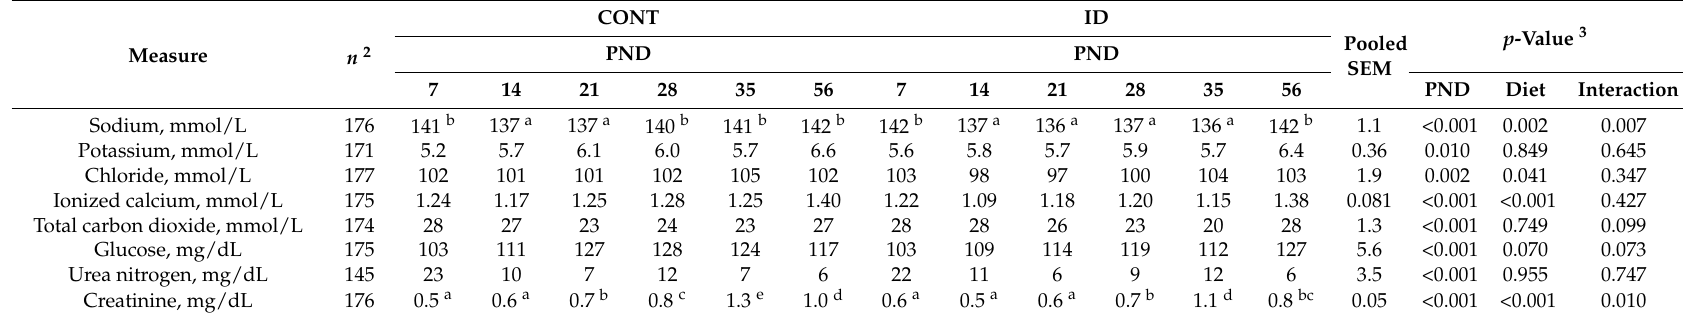
Table 3. Clinical blood chemistry outcomes of pigs differing in early-life iron status 1